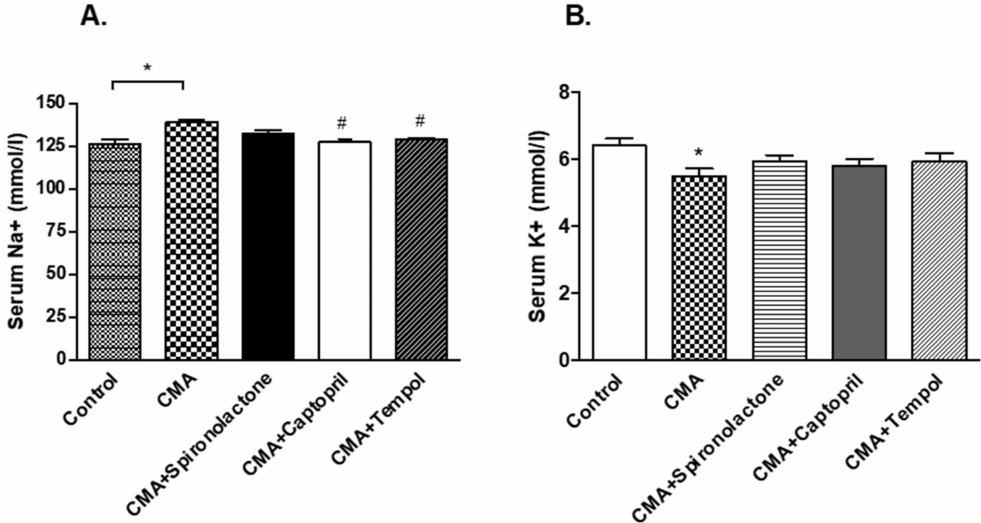
Figure 6. Serum sodium and potassium levels. Each bar represents values expressed as mean ± SEM. ( A ) The changes in serum sodium levels were considered significant when * p < 0.05 (control vs. CMA) groups and # p < 0.05 (CMA vs. CMA + captopril or CMA + tempol) groups. ( B ) The changes in serum potassium levels were significant when * p < 0.05 (Control vs. CMA) groups. The data were analyzed using one-way ANOVA followed by Tukey’s multiple comparison test among all five